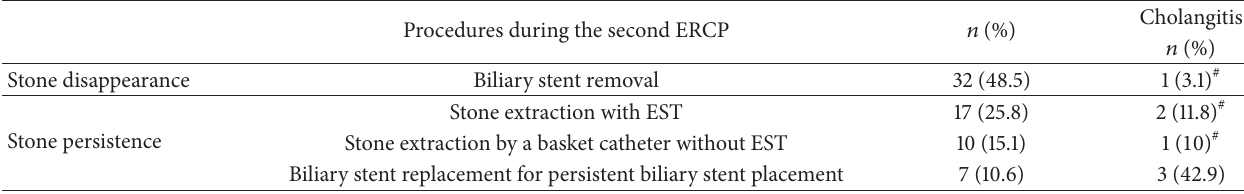
Table 6: Procedures during the second ERCP and cholangitis after the second ERCP.